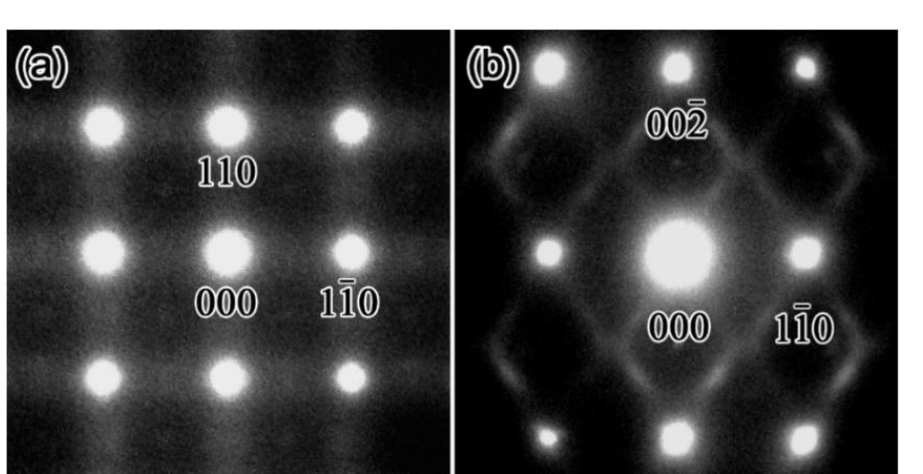
. Figure 8. Diffraction patterns of Zr-18 at.%Nb alloy. The zone axis is [001] in ( a ) and [110] in ( b